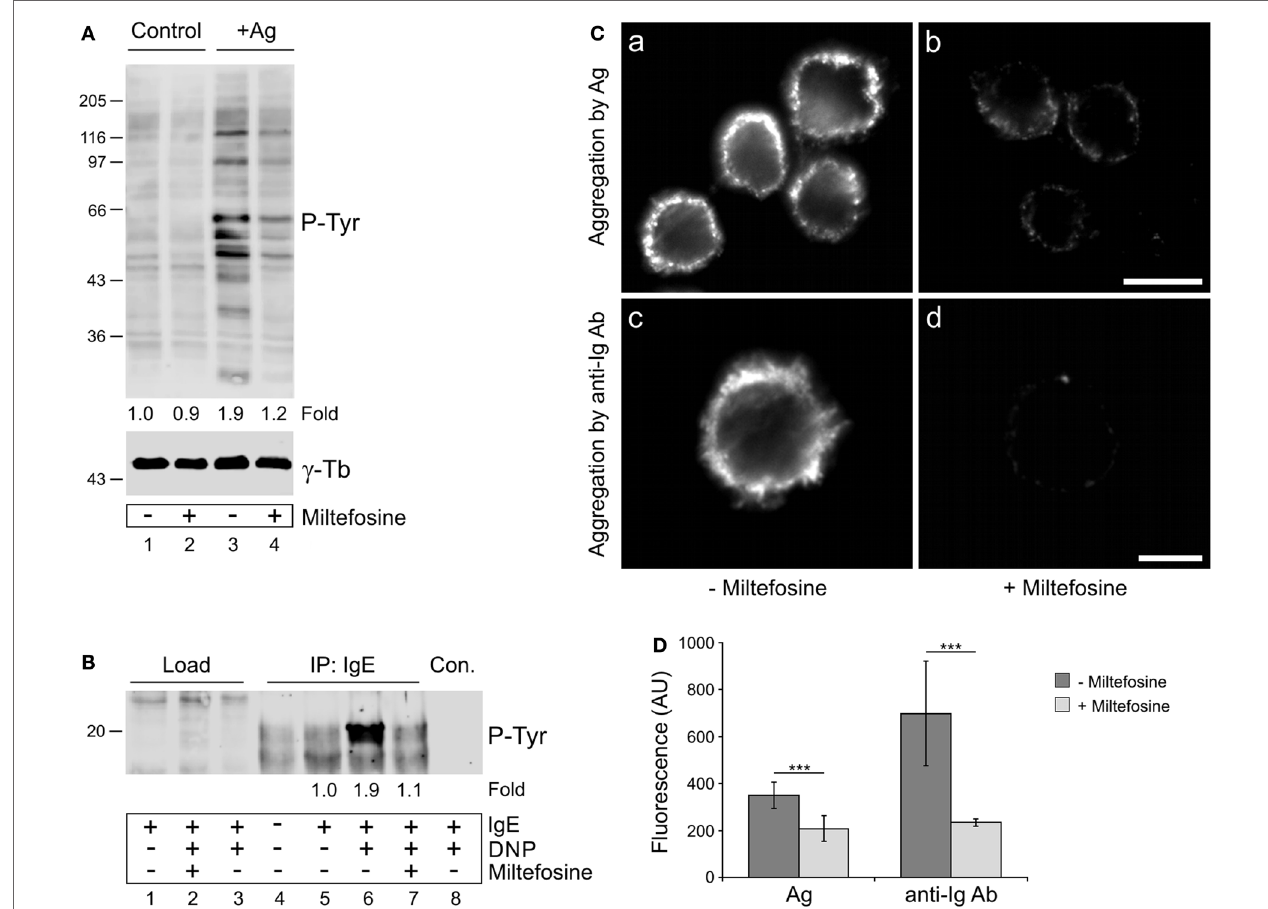
FigUre 3 | Miltefosine affects tyrosine phosphorylation and aggregation of high affinity IgE receptors (Fc ε RIs) in activated bone marrow-derived mast cells (BMMCs). (a) Comparison of protein tyrosine phosphorylation level (P-Tyr) in control cells and cells activated by Fc ε RI aggregation ( + Ag) in the absence (lanes 1 and 3) or presence (lanes 2 and 4) of miltefosine. γ -Tubulin ( γ -Tb) served as a loading control. Representative image out of three repetitions is shown. Numbers under the blot indicate relative amounts of P-Tyr normalized to control cells and to the amount of γ -tubulin in individual samples (fold). (B) Comparison of Fc ε RI receptor phosphorylation (P-Tyr) in the absence (lanes 1, 3–6, and 8) or presence (lanes 2 and 7) of miltefosine. Cells sensitized with mouse IgE to Ag were incubated with or without miltefosine, activated or not by Ag (DNP), and extracts were precipitated with anti-IgE Ab immobilized on protein A beads. In the control, protein A without Ab was incubated with the cell extract (lane 8, Con.). Note the difference in signal intensities in the positions of co-precipitated Fc ε RI receptors when cells were incubated without (lane 6) or with (lane 7) miltefosine. Representative image out of three repetitions is shown. Numbers under the blot indicate relative amounts of P-Tyr normalized to sensitized cells (fold). (a,B) Bars on the left indicate positions of molecular weight markers in kDa. (c) Comparison of Fc ε RI aggregation in the absence or presence of miltefosine. Cells sensitized with mouse IgE to Ag were incubated without (a,c) or with (b,d) miltefosine and activated by crosslinking of bound IgE with Ag (a,b; aggregation by Ag) or with anti-mouse Ig Ab conjugated with DY549 (c,d; aggregation by anti-Ig Ab). Cells were fixed with formaldehyde, and in the case of Ag-activated cells (a,b), stained with anti-mouse Ab conjugated with DY549. Images (a,b) and (c,d) were collected and processed under identical conditions. Scale bars, 10 µm (a,b); 5 µm (c,d). (D) Analysis of fluorescence intensity of Fc ε RI aggregation in the absence or presence of miltefosine. BMMCs were activated by crosslinking of bound IgE with Ag (Ag) or with anti-mouse Ig Ab (anti-Ig Ab). Values indicate mean ± SD (Ag, n = 30; anti-Ig Ab, n = 5); *** p <